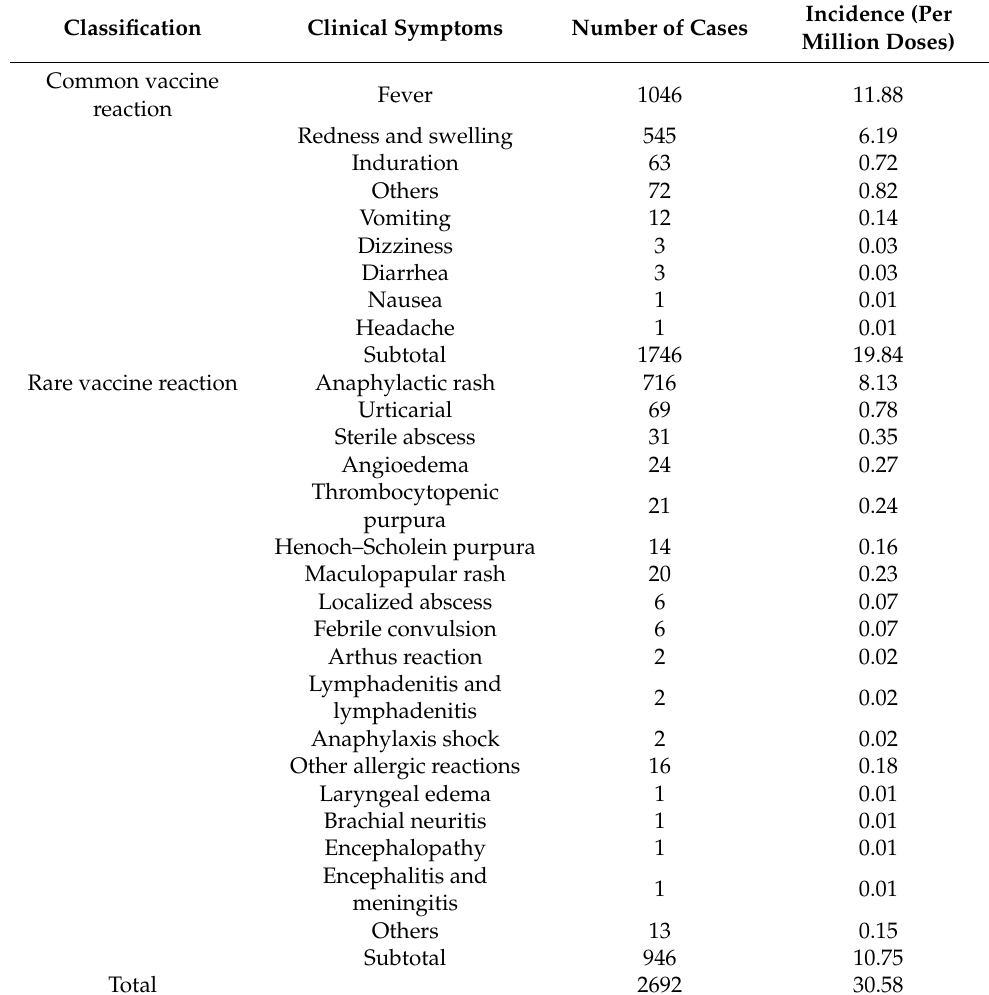
Table 3. Clinical symptoms of the adverse events related to HBV vaccination in Guangdong Province from 2005 to